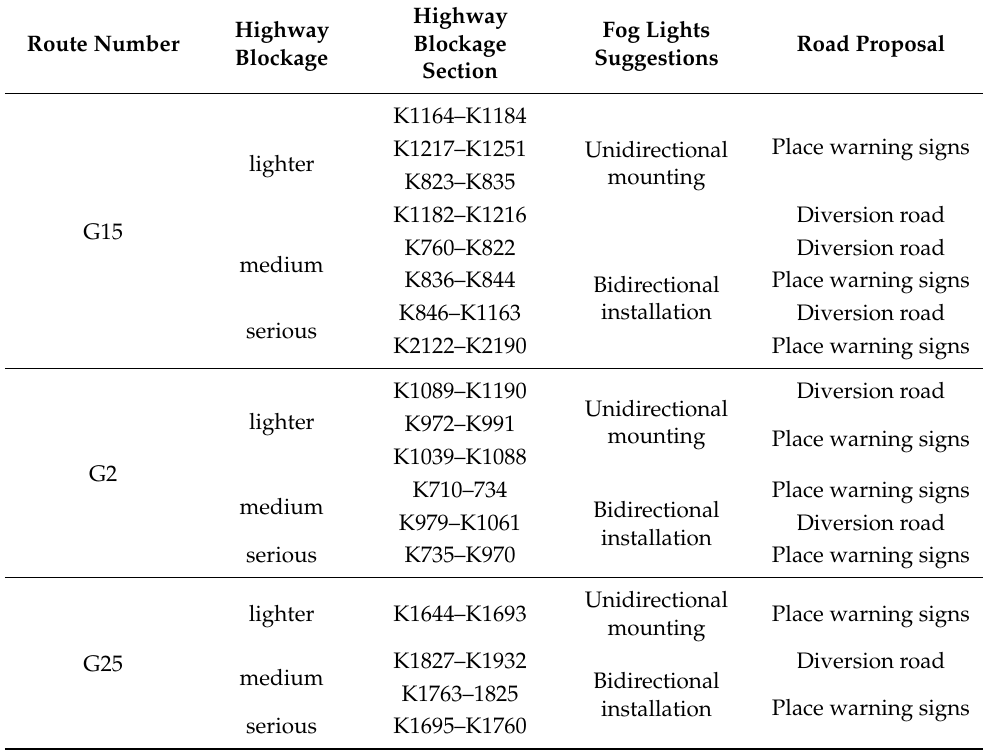
Table 4. Actions suggested by the traffic